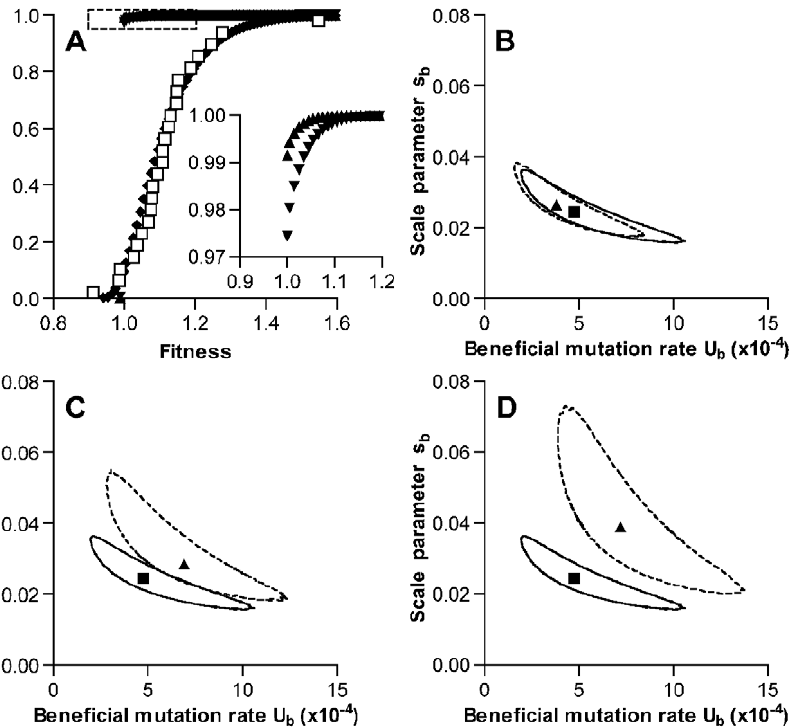
Figure 4. Simulation of fitness changes during single-colony serial transfer of S.pneumoniae . (A) The cumulative distribution of fitness values predicted by the ML model as described in the text is shown following the exponential phase of a single growth cycle (mutation only, triangles), after stationary phase of a single growth cycle (further mutation plus selection, inverted triangles), and after iteration of 126 growth cycles (diamonds). Values measured for experimental lines are shown as open squares for comparison. The inset expands the portion of the graph indicated by the dotted lines to show the frequencies of beneficial mutations within a single growth cycle. Parameters for the simulation shown were U b =4.8 6 10 2 4 , s b =0.025, U d =1.7 6 10 2 4 , and s d =0.012. Values for U b and s b represent ML estimates. Selection was permitted throughout stationary phase, and mutation rates were held constant during the growth cycle. (B–D) ML estimates for U b and s b derived under different model assumptions. Results obtained for the set of conditions used in A, while allowing U b and s b to vary, are shown in each panel for comparison with a square symbol (ML estimate) and solid line (95% confidence contour). The effects of varying a single model condition on ML values and 95% confidence contours are shown with triangles and dotted lines, respectively. Alternative model conditions were (B) no deleterious mutations, (C) selection limited to the final 6 time intervals of stationary phase, and (D) no selection.